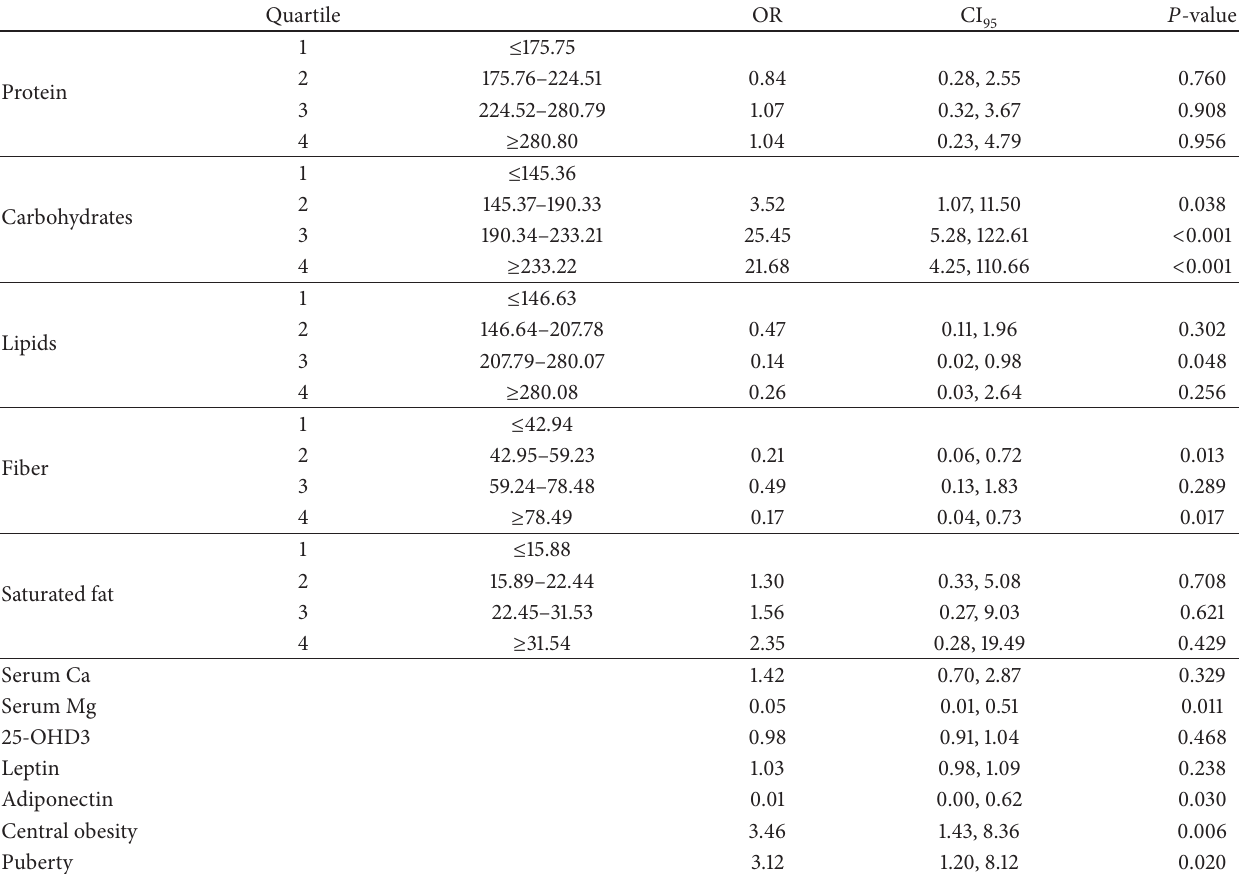
Table 3: Determinants of insulin resistance measured as HOMA > 3.16 ∗ .